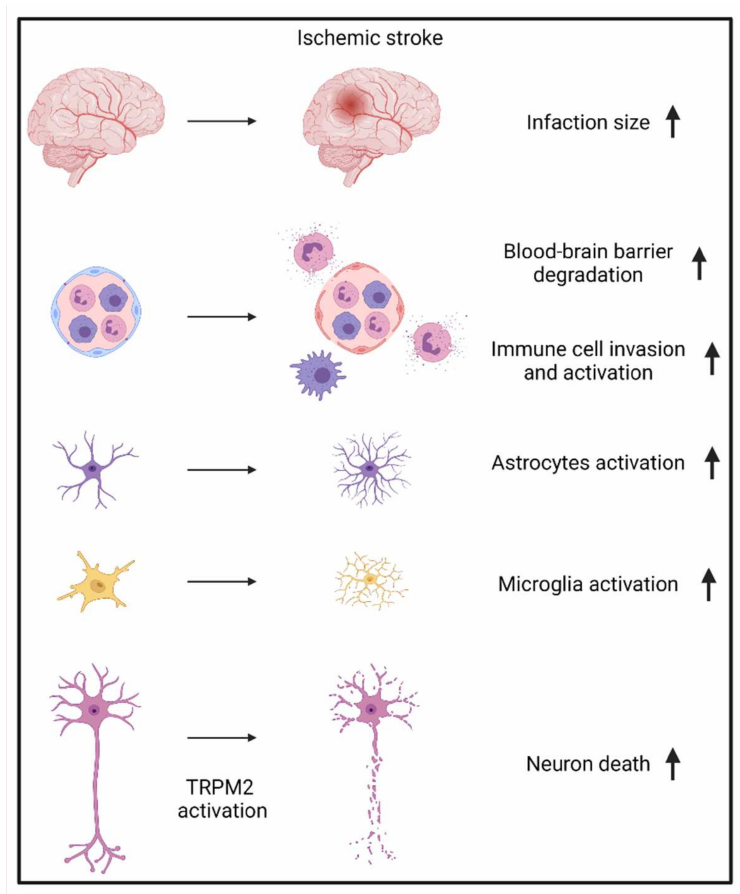
Figure 4. TRPM2 in ischemic